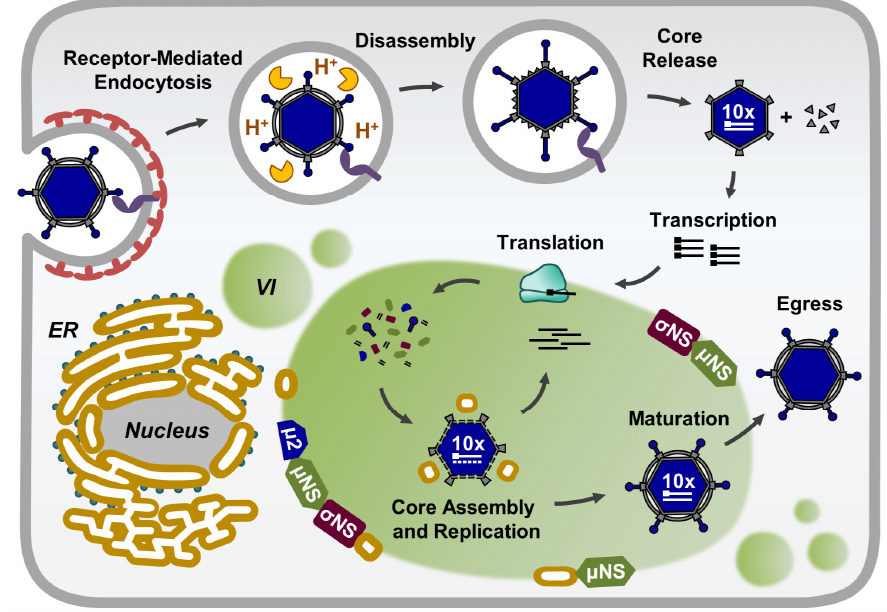
Figure 1. The reovirus replication cycle. VI—viral inclusions; ER—endoplasmic reticulum.